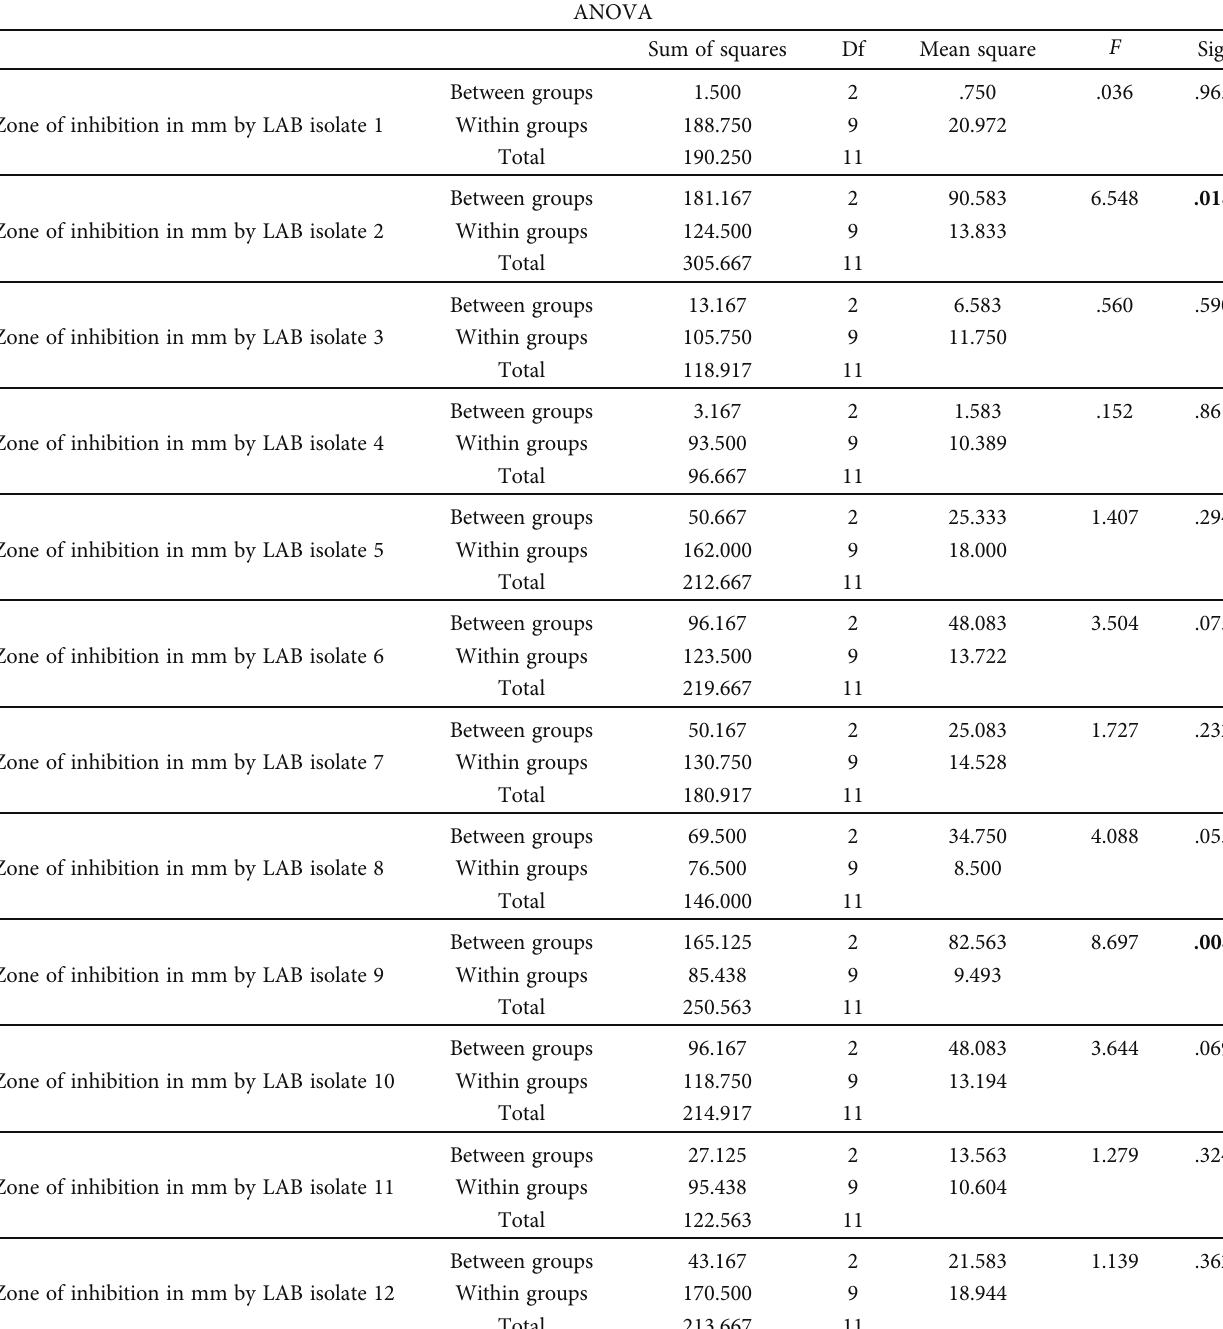
ANOVA Sum of squares Df Mean square F Sig.